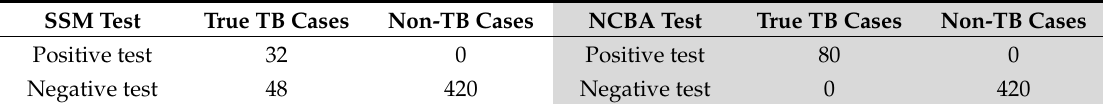
Figure 3. Result of the 500-sample analysis. Sputum Smear Microscopy (SSM) is shaded while nanoparticle-based colorimetric biosensing assay (NCBA) and Xpert MTB/RIF are not shaded. For the SSM test, 32 were positive (32+) and 468 were negative (468 − ); The 32+ SSM samples were all positive in Xpert and NCBA. Of the 468 − (negative) SSM samples, 48 were positive and 420 were negative in both NCBA and Xpert MTB/RIF. Table 1. Results using Xpert MTB/RIF as the gold standard for true tuberculosis (TB) cases and non-TB cases.